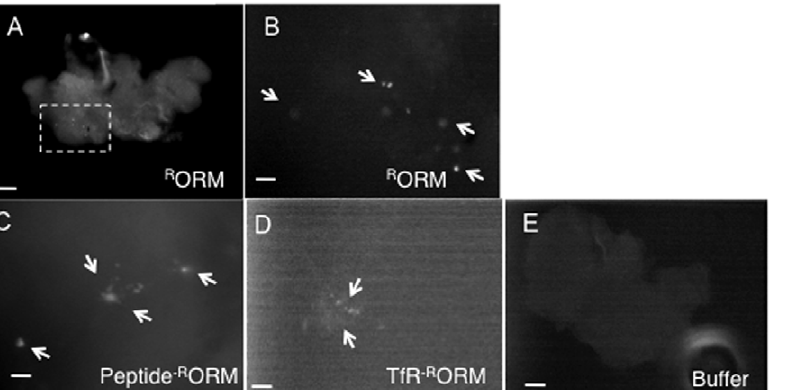
Figure 6. ORMOSIL incorporates into living adult neuronal tissues. (A) Unconjugated ORMOSIL is observed in adult fly brains. A representative fluorescence image of an adult brain from a fly that was fed on R ORM from the time it was a larvae was dissected and observed using the 568 nm filter. R ORM aggregates are observed within the adult brain. Images were taken using the 10 6 objective. The boxed region is enlarged in B. Bar=10 m m. (B) Unconjugated ORMOSIL aggregates are observed as puncta within adult fly brains. A high magnification (using the 100 6 objective) image of the boxed region from A. R ORM aggregates (arrows) are seen as puncta within the adult brain. Interestingly, in all 6 adult brains imaged showed similar puncta of ORMOSIL. Bar=5 m m. (C) Peptide conjugated ORMOSIL aggregates are observed as puncta within adult fly brains. A representative high magnification image shows peptide- R ORM puncta within the adult brain (arrows). Bar=5 m m. (D) Receptor conjugated ORMOSIL aggregates are observed as puncta within adult fly brains. A representative high magnification image shows TfR- R ORM puncta within the adult brain (arrows). Bar=5 m m. (E) No fluorescence is observed in buffer fed adult fly brains. A representative image from a buffer (1XPBT) fed adult fly brain imaged using the 568 nm filter. Note that there is no fluorescence in these brains. Images were taken using the 10 6 objective. Bar=10 m